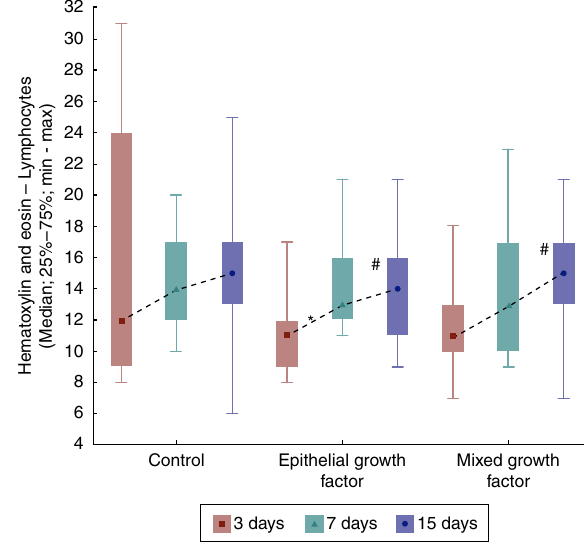
Figure 5 Hematoxylin and eosin evolution --- lymphocytes in each wound, assessment.